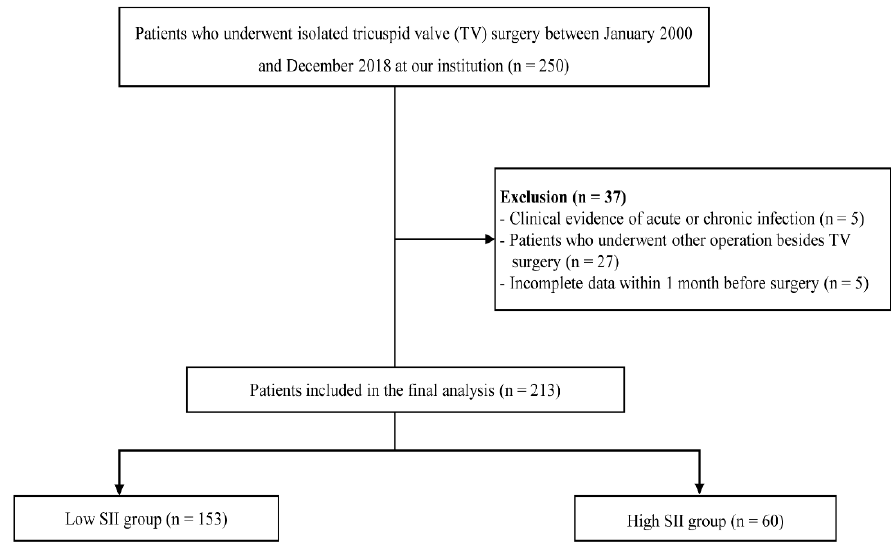
Figure 1. Flowchart of the patient selection and classification. SII, systemic immune-inflammation index.